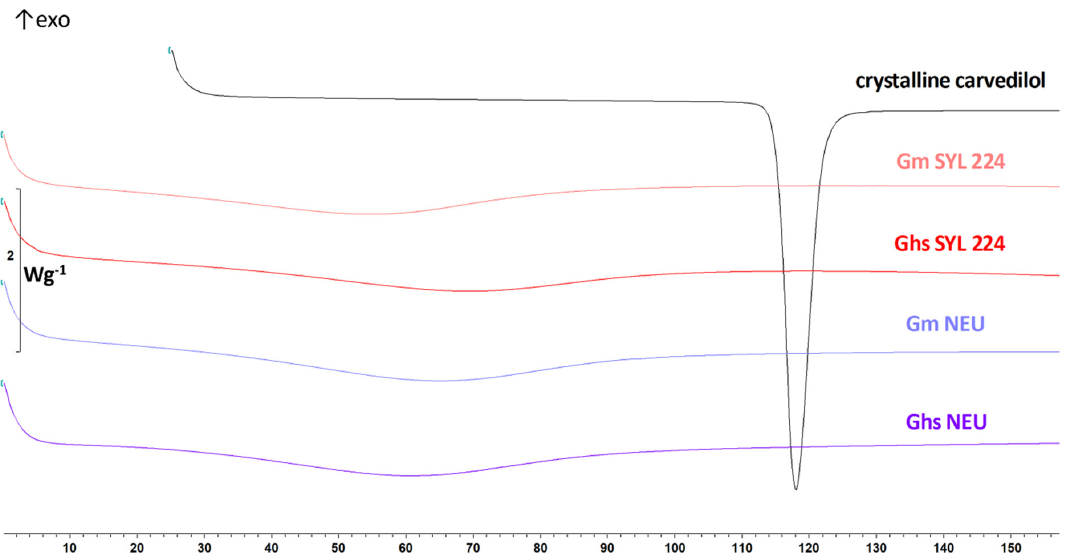
Figure 4. DSC curves, representing pure crystalline carvedilol and produced granules G m SYL 224 , G hs SYL 224 , G m NEU and G hs NEU.